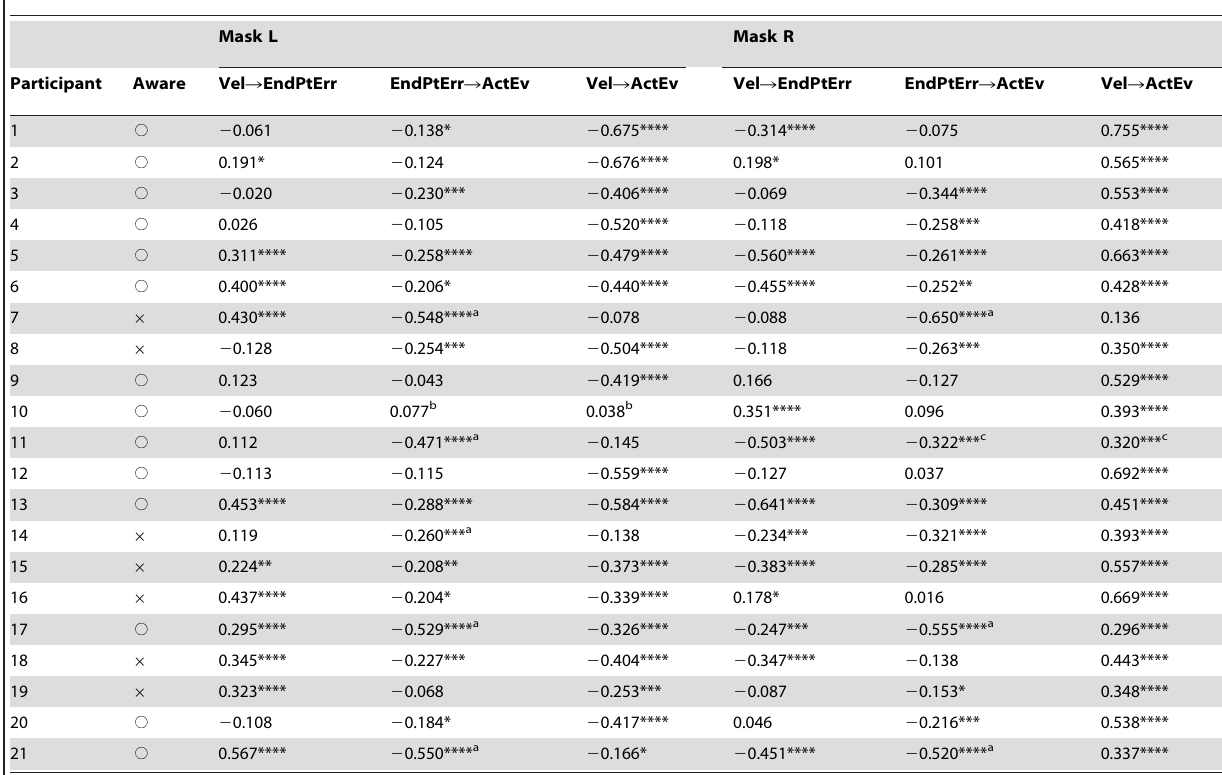
Table 1. Standardized path coefficients of each participant in the practice phase in the model in Fig.